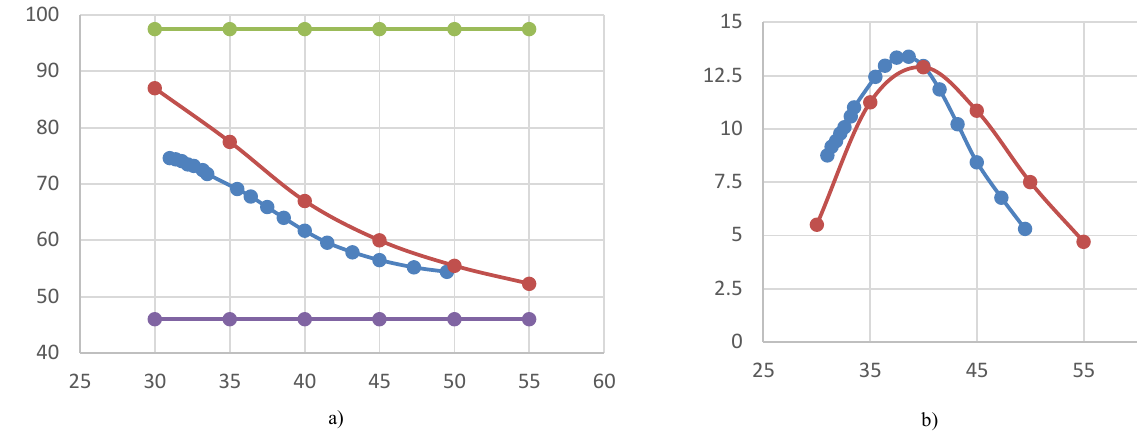
Fig. 2 Theory versus experiment for fundamental bending mode at different temperatures ranging from 30°C to 55°C. a) Fundamental frequencies; 17 blue dots: experiments; 5 red dots theory; the top and bottom lines are the fundamental frequency of respectively the monolithic and the bi-layer Kirchhoff plate. b) Damping versus temperature; 17 blue dots: experiments; 5 red dots